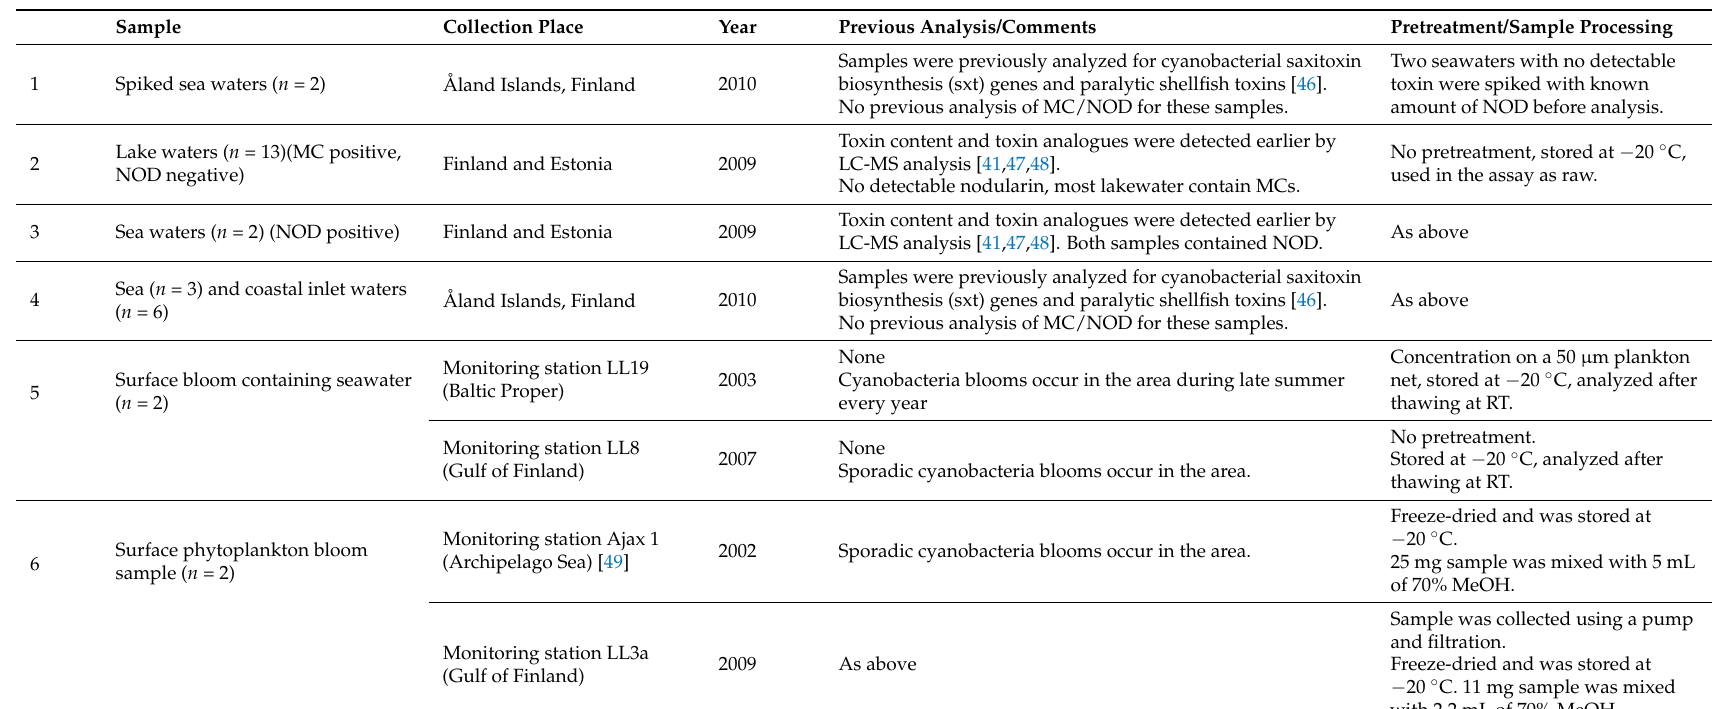
Table 1. Analyzed environmental water and bloom